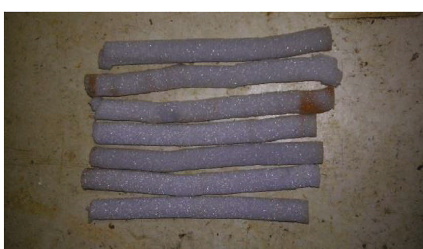
Figure 4: Polyurethane foam materials (mini-PUF) are used for passive